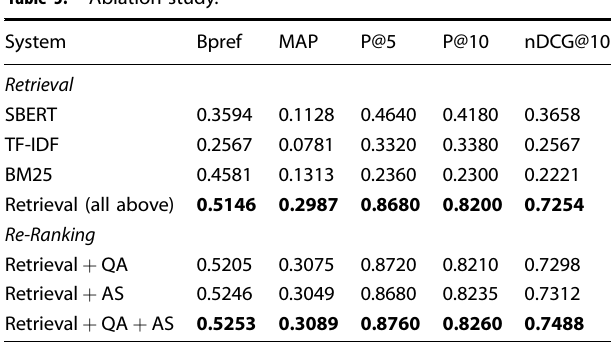
Table 3. Ablation study.